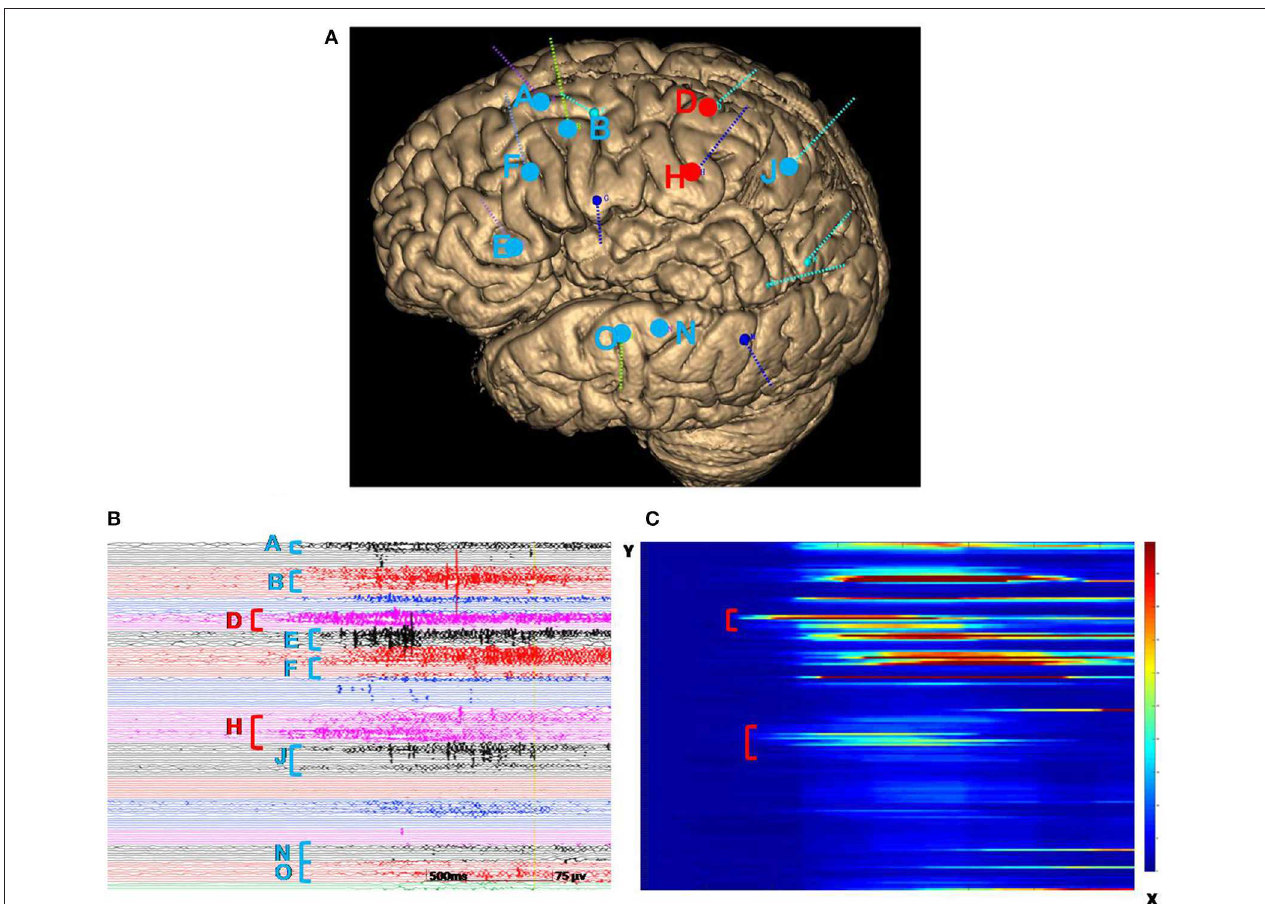
FIGURE 2 | (A) A three-dimensional MRI reconstruction of the depth electrodes. (B) Ictal SEEG recording revealed that the first electrodes involved in the seizure were from the cingulate sulcus and insular pole (electrodes D and H, marked by red vertical bars). Then the midcingulate cortex, inferior part of the insula, anterior short gyrus, anterior part of the insula, precuneus, superior temporal gyrus, and operculum quickly became involved (electrodes A, B, E, F, J, N, and O, marked by blue vertical bars). The color of the letters is consistent with the dots in illustration A. (C) The x -axis represents the time of the selected seizure; the y -axis indicates electrodes. The energy ratio (ER) of high-frequency changes was depicted in a color scale (from red to blue, the ER intensity decreased). Quantification of the seizure was consistent with visual analysis, indicating that the cingulate sulcus and insular pole (marked in red) were involved first. SEEG,